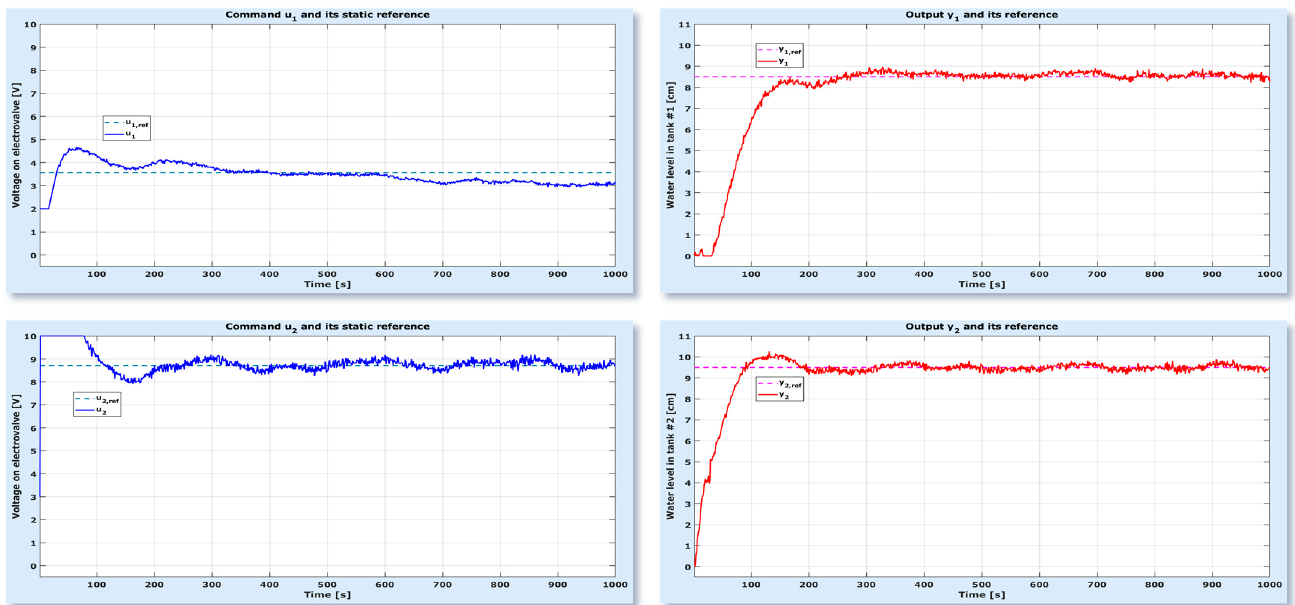
Figure 17. I/O signals for optimal PID-N controllers; in the case of <raw> idmo, IFA